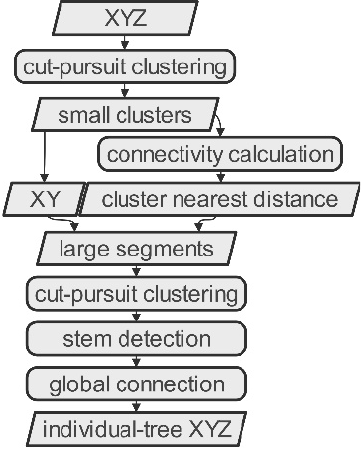
Figure 3. treeiso ’s workflow.